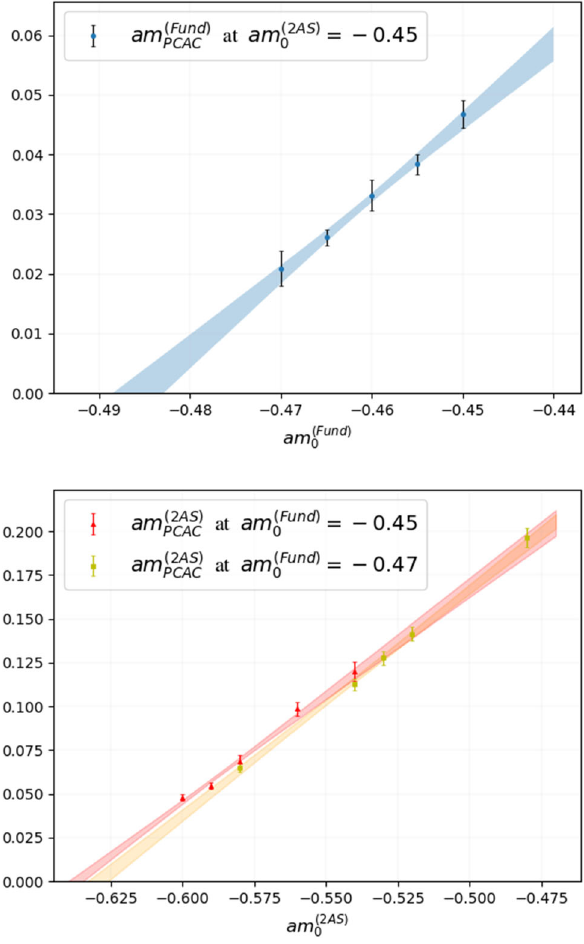
Fig. 5 Three chiral extrapolations, one on the top for fundamental fermions and two on the bottom for antisymmetric fermions. The bands correspond to linear fits. The heavier point in the plot on the top was also present in [9]. In the top panel, the fit has χ 2 / d . o . f . = 0 . 23 . In the bottom panel, χ 2 / d . o . f . = 2 . 22 for am